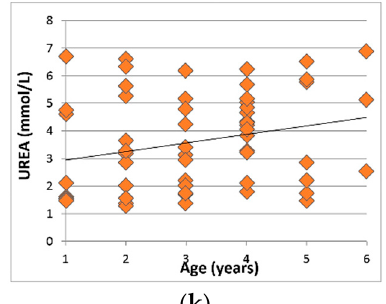
Figure 1. The influence of age on ( a ) Glucose (GLU); ( b ) Alkaline phosphatase (ALP); ( c ) Alanine aminotransferase (ALT); ( d ) Alkaline phosphatase (AST); ( e ) Alkaline phosphatase (BILT); ( f ) Cholesterol (CHOL); ( g ) Creatinine (CREA); ( h ) High-density lipoprotein (HDL); ( i ) Calcium (Ca); ( j ) Triglycerides (TRIGL); ( k ) Urea (UREA).